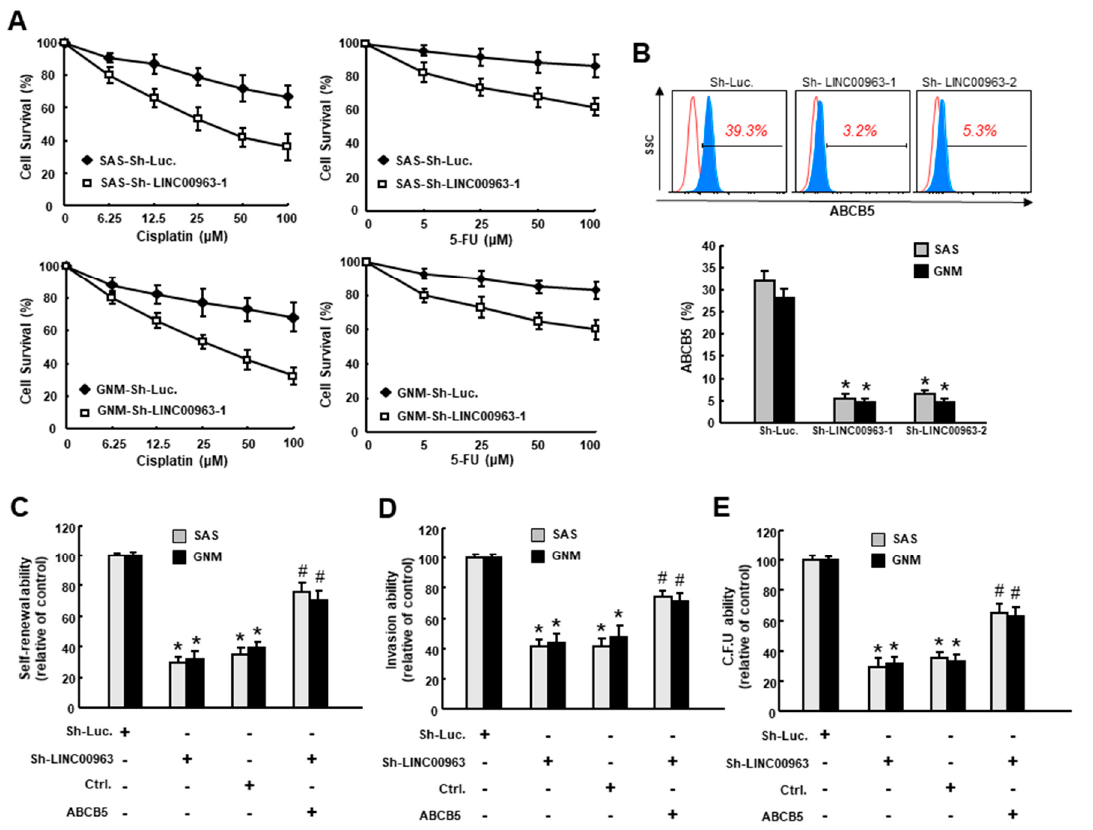
Figure 5. The silence of LINC00963 sensitizes chemotherapy and downregulates CSC features through suppression of ABCB5. ( A ) Cell survival of OSCC cells transfected with sh-Luc or sh-LINC00963 in response to Cisplatin (left) and 5-FU (right) treatment; ( B ) proportion of ABCB5-expressing OSCC cells transfected with sh-Luc or sh-LINC00963 using flow cytometry; overexpression of ABCB5 rescued the inhibited ( C ) self-renewal, ( D ) invasion, and ( E ) colony-forming abilities in cells transfected with sh-LINC00963. Experiments were repeated three times and representative results were shown. Results are means ± SD of triplicate samples from three experiments. * p < 0.05 sh-LINC00963 group compared to the sh-Luc group. # p < 0.05 ABCB5 overexpression + sh-LINC00963 group compared to sh-LINC00963 group.